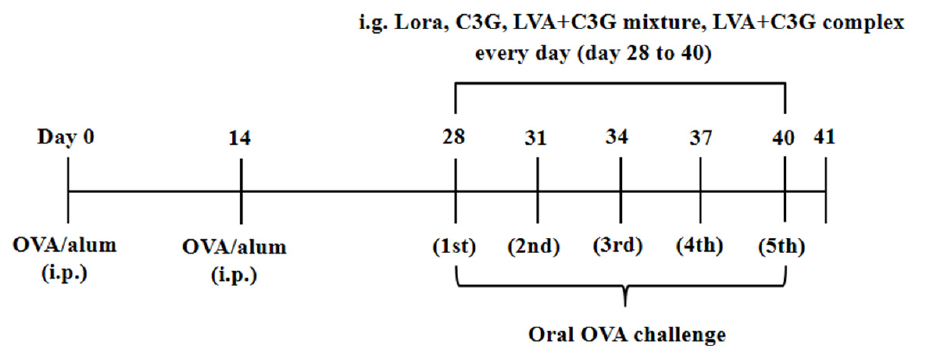
Figure 1. The protocol for the FA model.